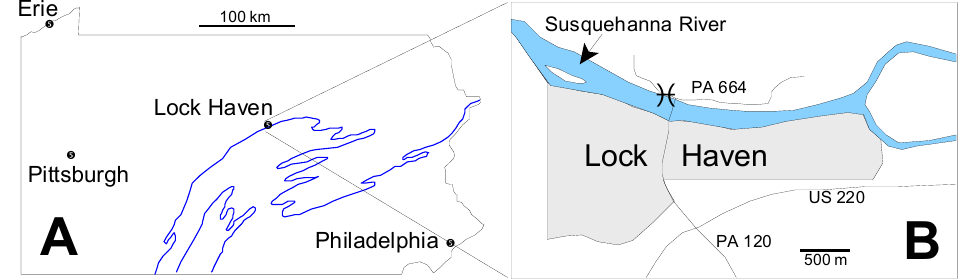
Figure 1. Locality Maps. ( A ) Map of Pennsylvania showing the location of Lock Haven. The main outcrop belt of the Tully Formation and its lateral equivalents is shown in the blue line; ( B ) Detailed map of the Lock Haven area. Star shows the site of the Tully exposure from which the microfossils described here derive. PA664 and PA120 refer to Pennsylvania state highways. US220 identifies a US federal highway. North is toward the top of the page in both maps.